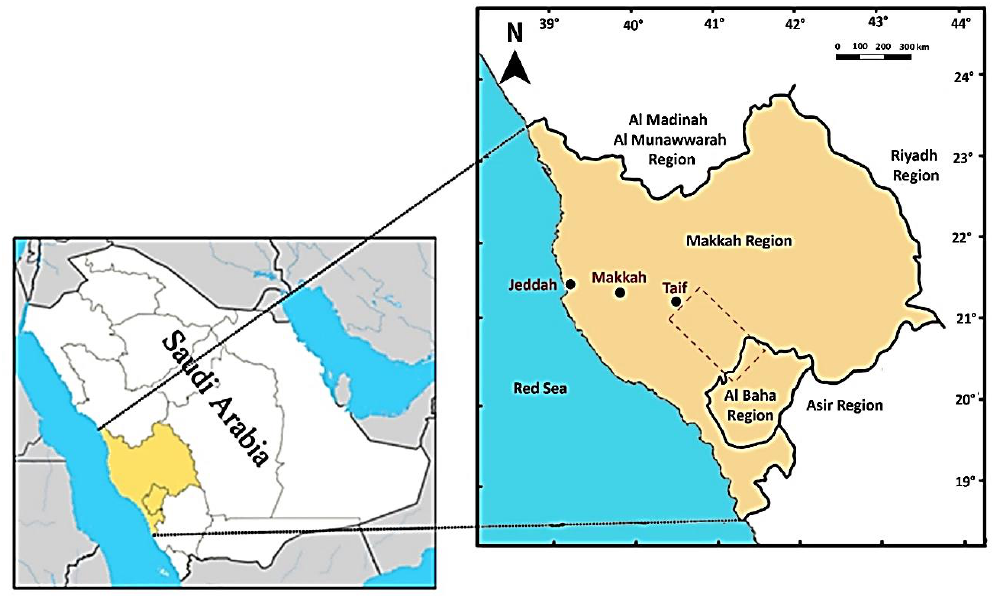
Figure 1. Location of the study area, the dashed polygon extends south from Taif in Makkah province to the northern edge of Baha province, Saudi Arabia.